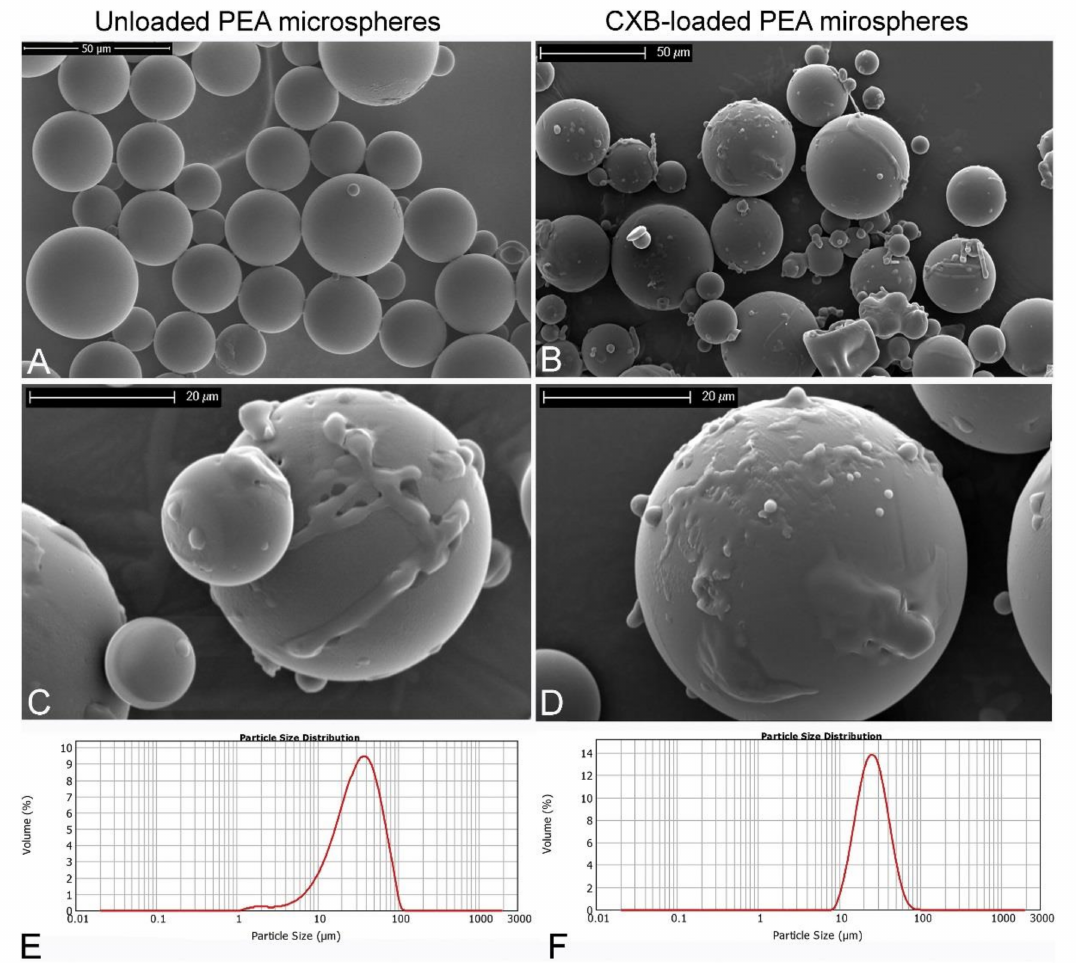
Figure 1. Scanning electron micrographs of polyesteramide (PEA) microspheres. ( A , C ) Control microspheres. ( B , D ) Microspheres loaded with celecoxib (CXB). ( E , F ) Respective particle size distributions. Scale bars are 50 µ m in ( A , C ) and 20 µ m in ( B , D ). Reproduced under the terms of a Creative Commons Attribution License from [18]. © 2021 The Authors. Published by